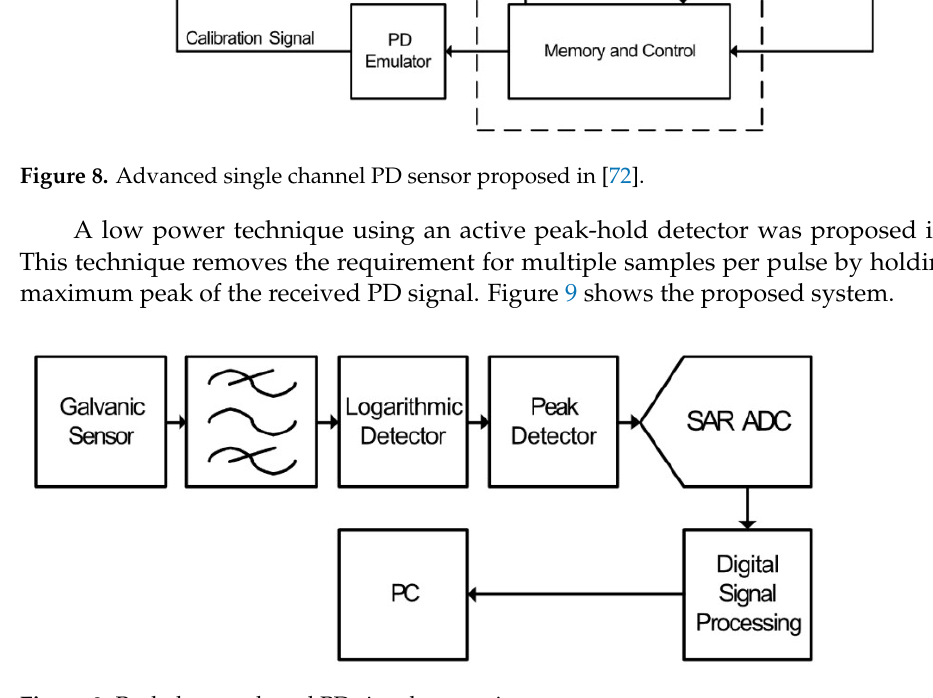
Figure 9. Peak detector-based PD signal processing.